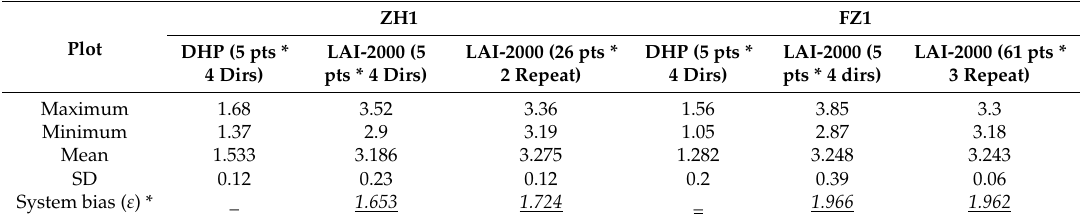
Table A2. Comparison of effective LAI derived from digital hemispherical photography (DHP) and LAI-2000 methods.